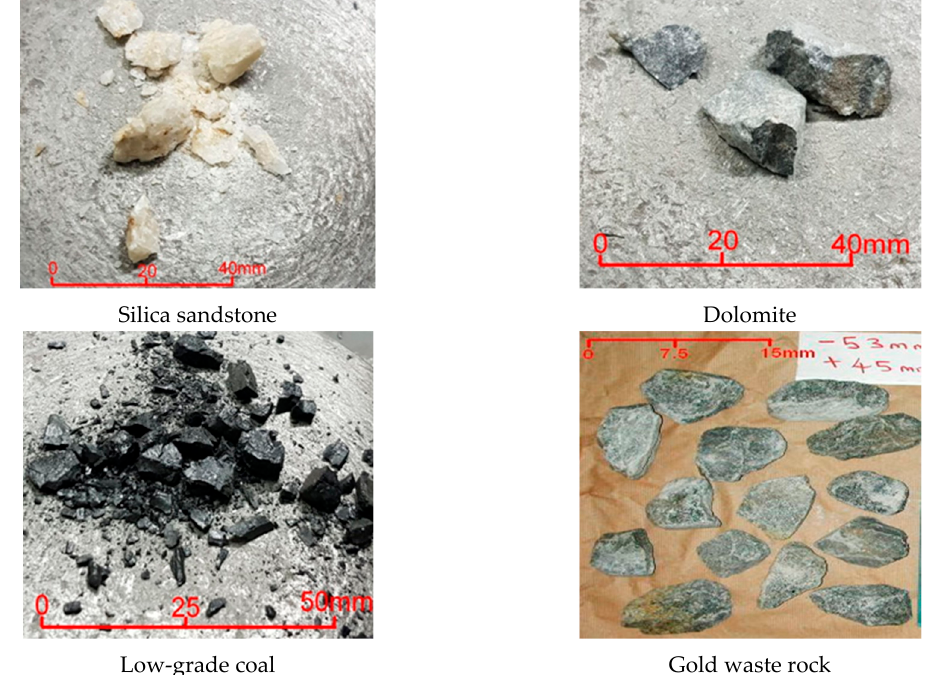
Figure 5. Display of the samples of material used in the drop weight tests.